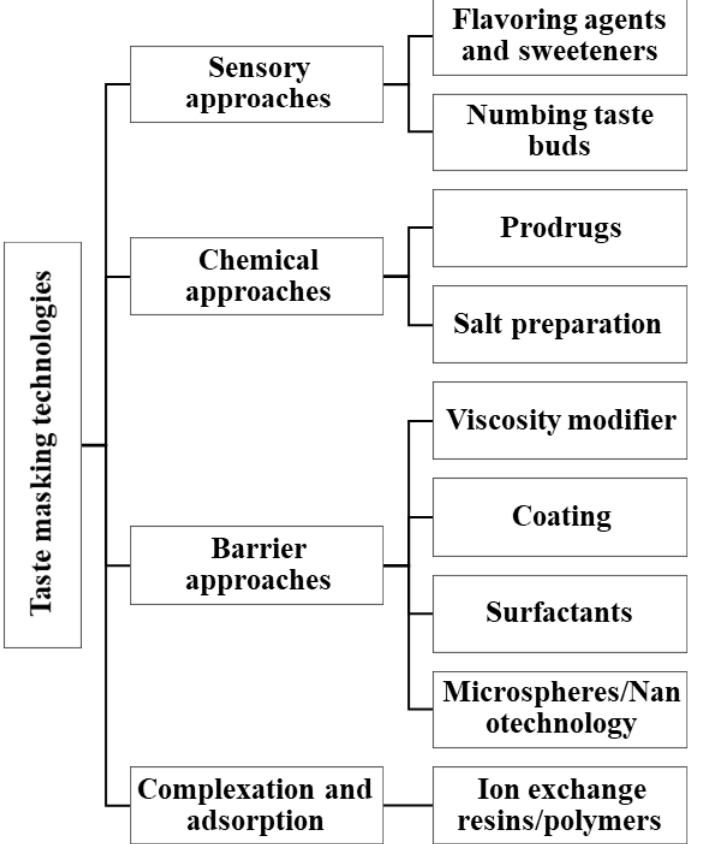
Figure 3. Pharmaceutical technology techniques for taste masking that would need to be assessed for safety in pediatric formulations. safety in pediatric